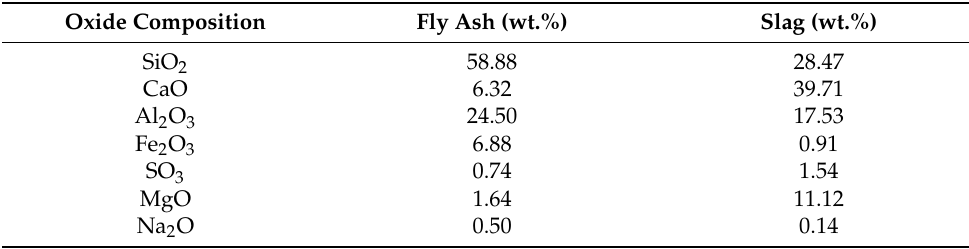
Table 1. Chemical composition of fly ash and slag used in this study. Oxide Composition Fly Ash (wt.%) Slag